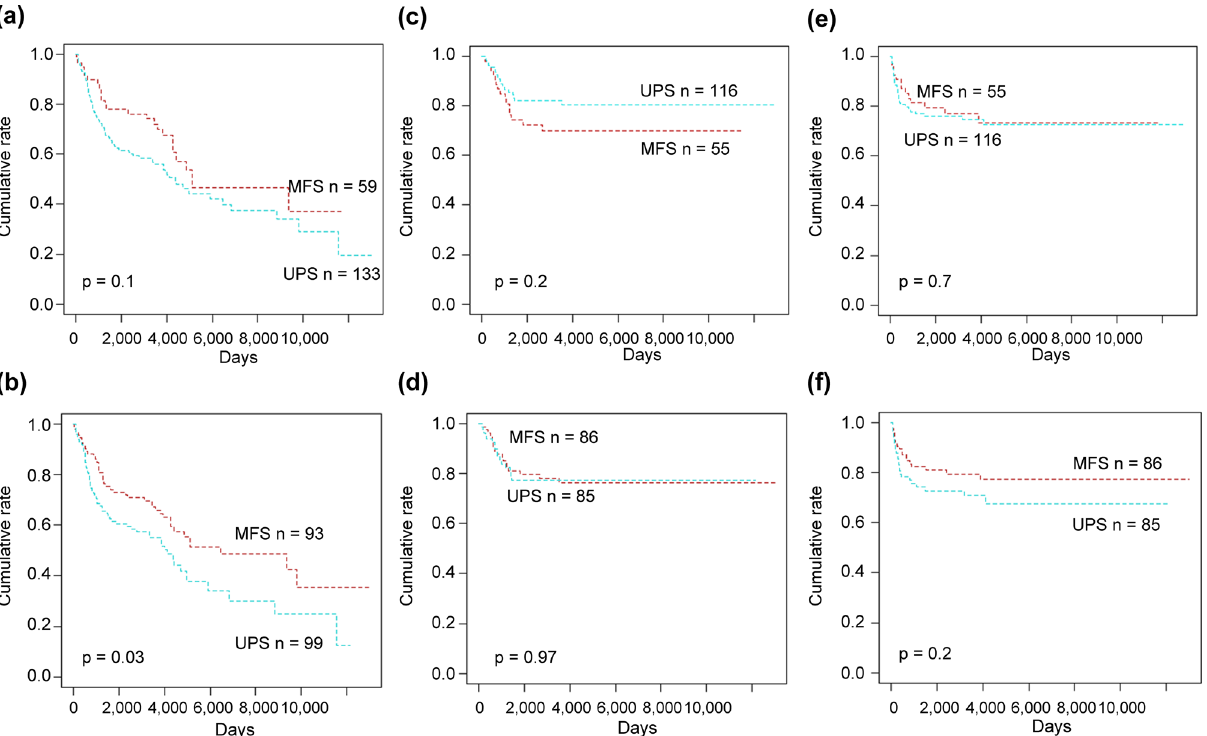
Figure 2. Survival curves of patients with myxofibrosarcoma (MFS) and undifferentiated pleomorphic sarcoma (UPS). When MFS was defined as a myxoid component of > 50%, there was no significant difference in overall survival between patients with MFS and those with UPS ( a ). On the other hand, patients with MFS showed significantly better overall survival than did those with UPS when MFS was defined as having a myxoid component > 10% ( b ). Local recurrence-free survival didn’t show significant differences between patients with the two types of diseases under the both definition of MFS ( c : myxoid component of > 50%; d : > 10%). Distant metastasis-free survival also didn’t show significant differences between patients with the two types of diseases under the both definition of MFS ( e : myxoid component of > 50%; f : >